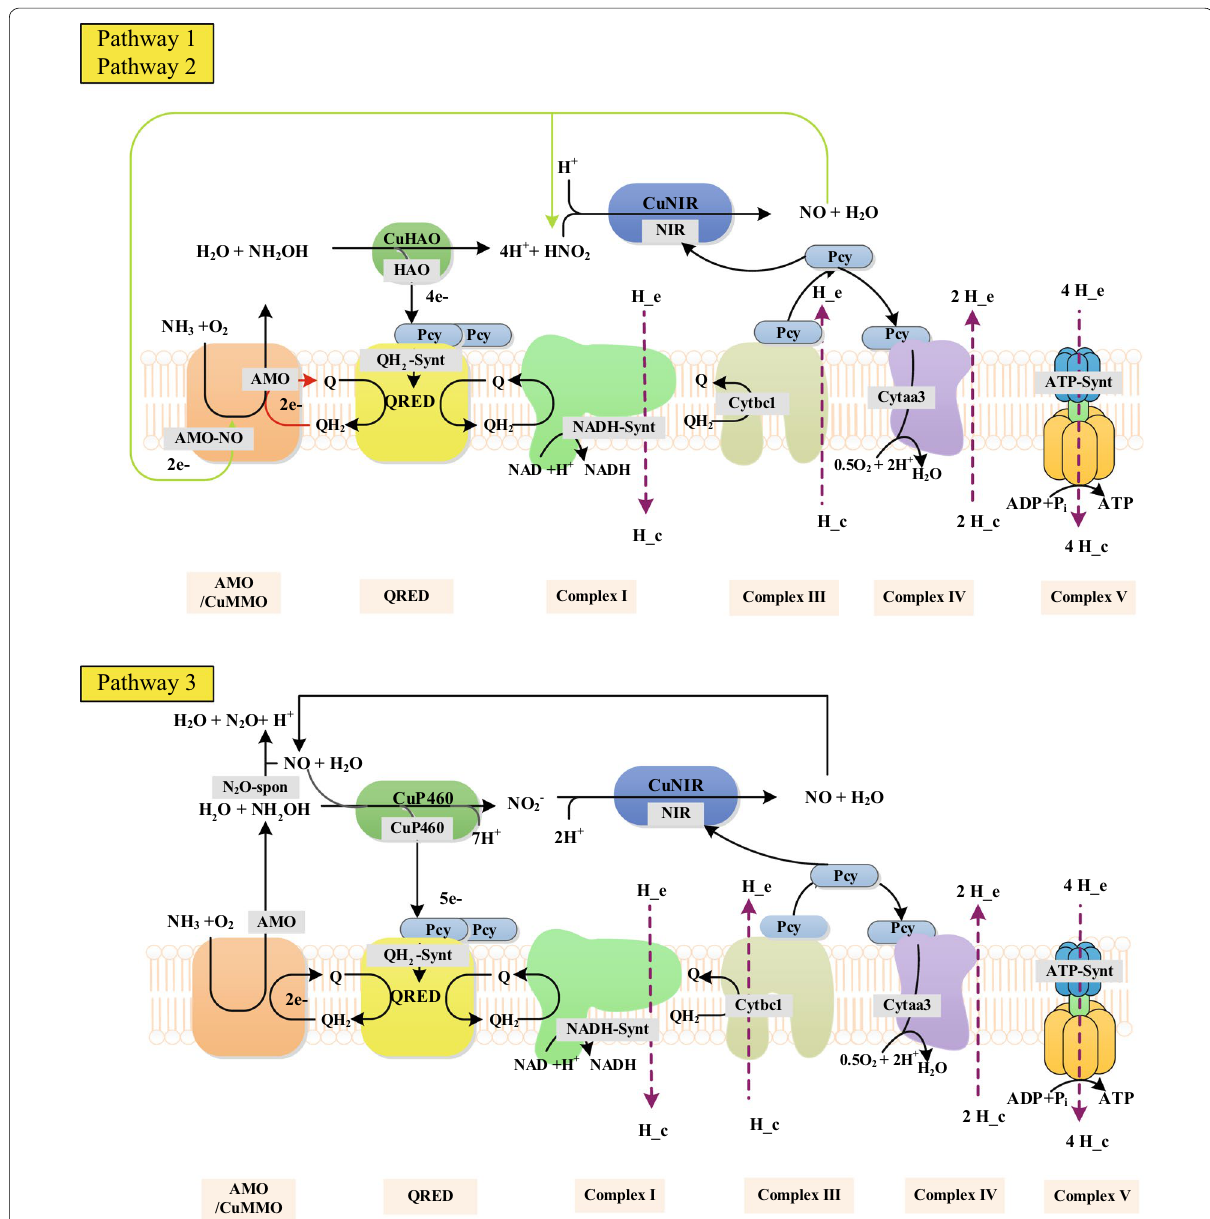
Fig. 5 Outline of the reconstructed strain SCM1 metabolic network